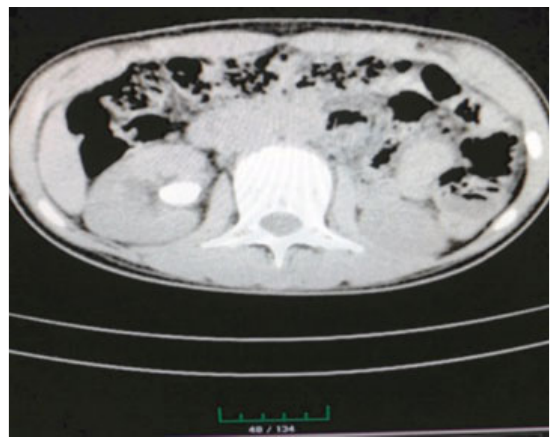
Fig. 1 A noncontrast computed tomography scan showing a 2-cm stone in the right renal pelvis.